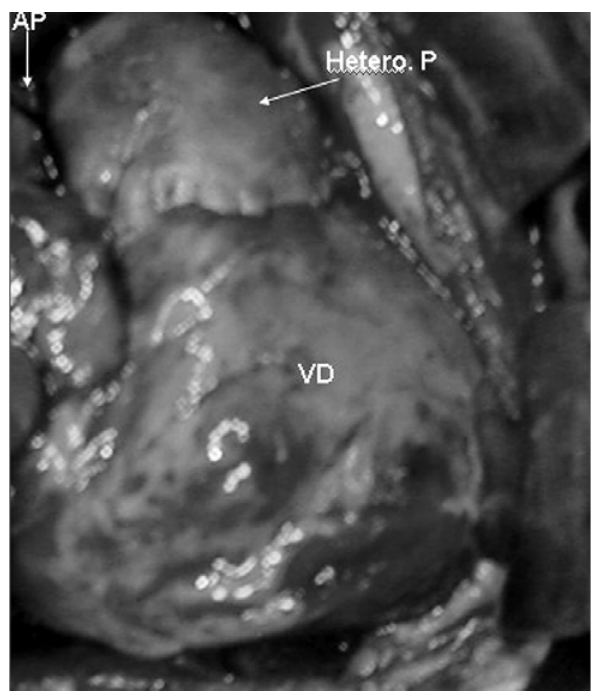
Fig. 7 - Fotografia cirúrgica. Reconstrução da junção ventrículo direito (VD) - artéria pulmonar (AP), com heteroenxerto pulmonar (Hetero.